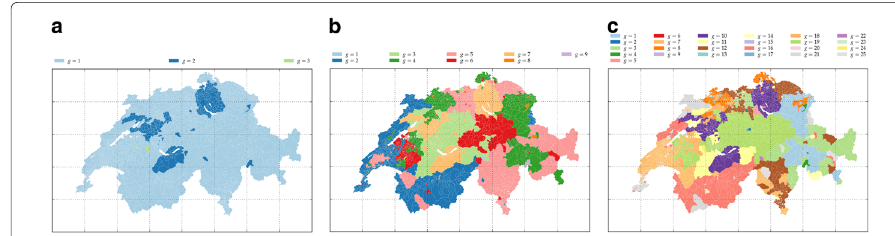
Fig. 7 The maps of the groups obtained by hard k-means clustering on the MDS over the generalised χ 2 distance between municipality profiles in the term-municipality matrix. From a to c the parameters are: m = 3, θ = 1.01; m = 9, θ = 0.5; m = 25, θ =